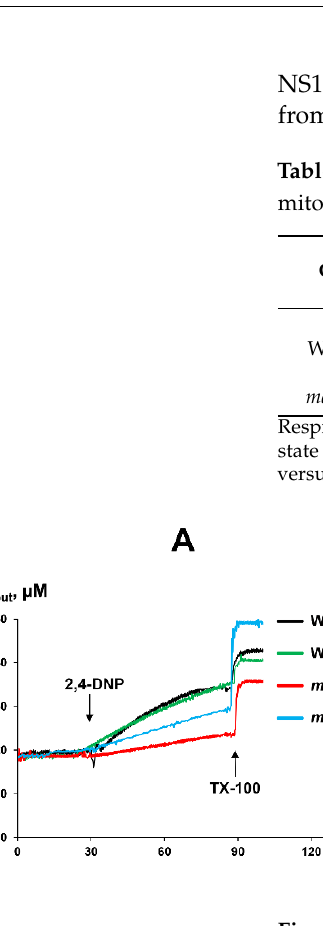
Figure 1. The effect of NS1619 (NS) on DNP-induced potassium efflux from mouse skeletal muscle mitochondria ( A ). Potassium release rate ( B ) and total content of potassium ions ( C ) in skeletal muscle mitochondria. Additions: 50 µM of 2,4-DNP and triton X-100 (TX-100, 0.1%). The data are presented as m ± SEM.